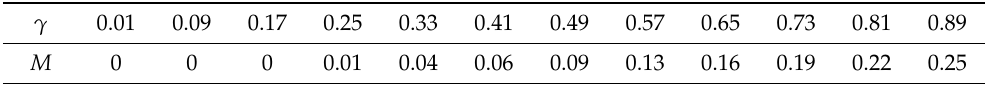
√ √ γ ,1/ γ ) and several